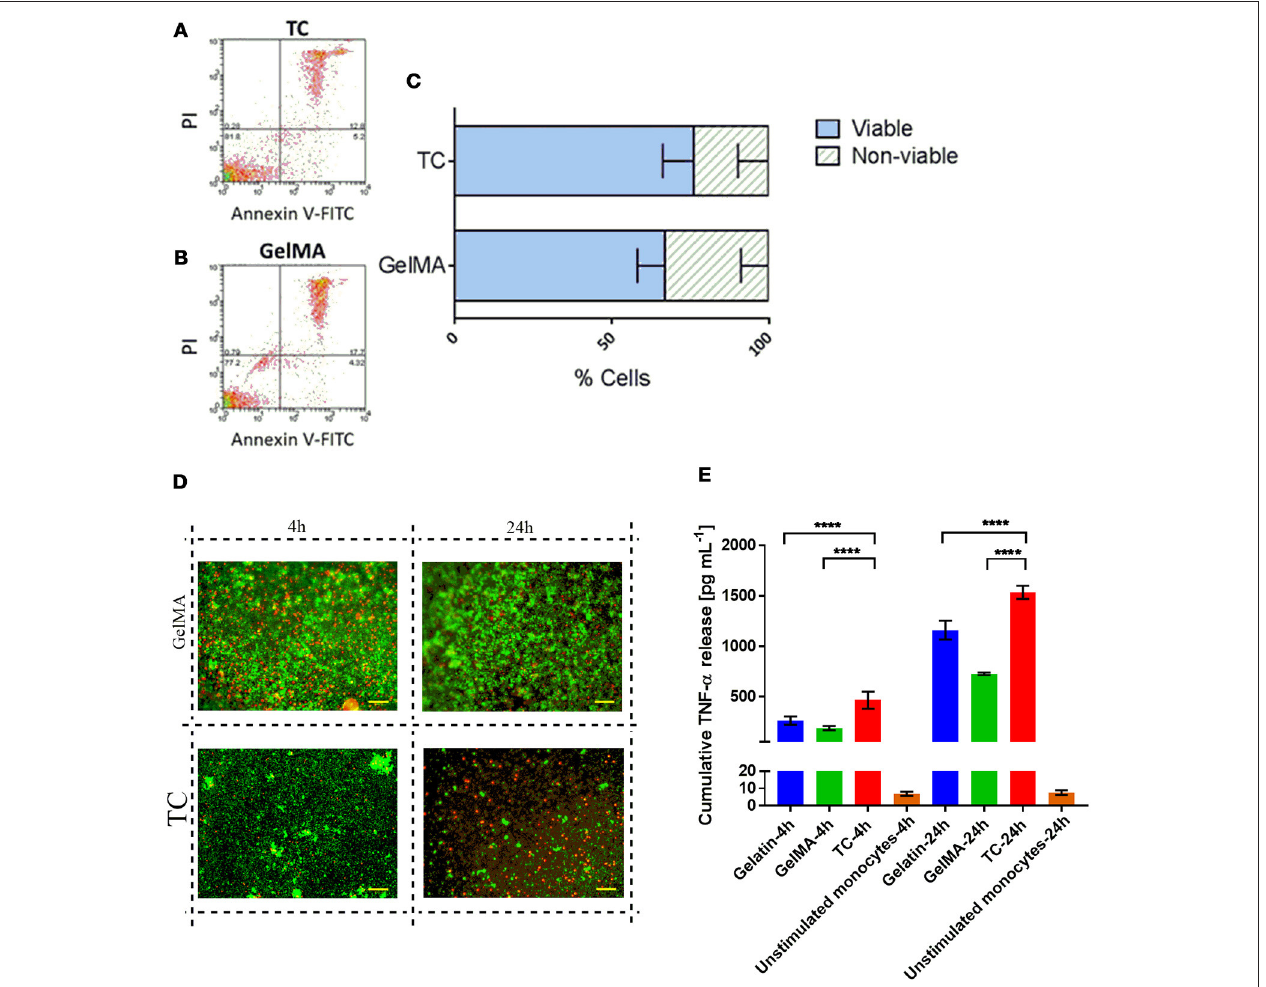
FIGURE 1 | PBMC viability is not impaired by culture with GelMA hydrogels. (A,B) Annexin V-FITC/PI staining profiles of cells harvested from TC and GelMA cultures respectively. (C) Percentage of viable (dark gray bars) and non-viable (light gray bars) cells collected from GelMA and TC. Two-tailed t -tests determined that there were no significant differences ( P > 0.05) in the proportion of viable cells, or dead cells harvested from GelMA cultures compared to TC. Error bars represent standard deviation ( n = 3). (D) Live/Dead staining of PBMC on GelMA and TC for 4 and 24h (scale bar 100 µ m) where green fluorescent highlights live and red highlights dead cells respectively. (E) Measurement of TNF- α production by LPS stimulated CD14 + monocytes seeded on different substrates. **** p < 0.0001.